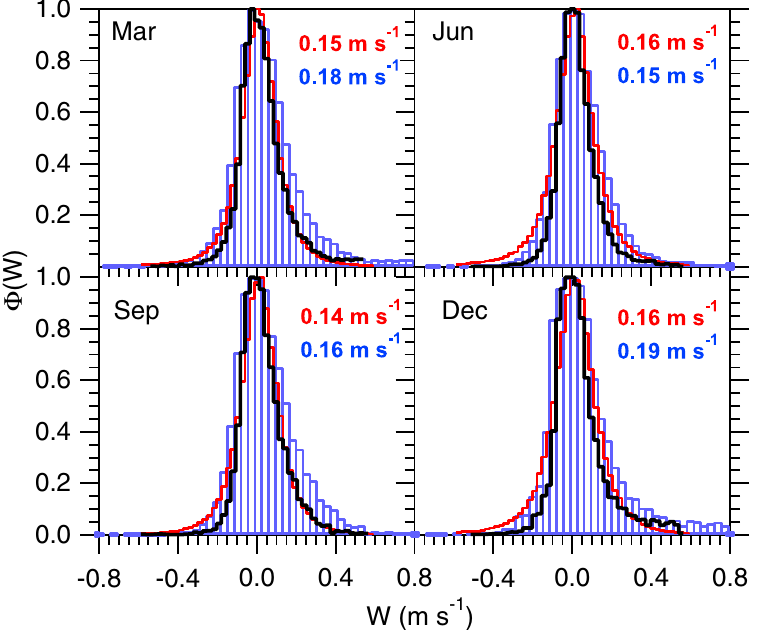
Figure 2. Similar to Fig. 1 but for the Manus